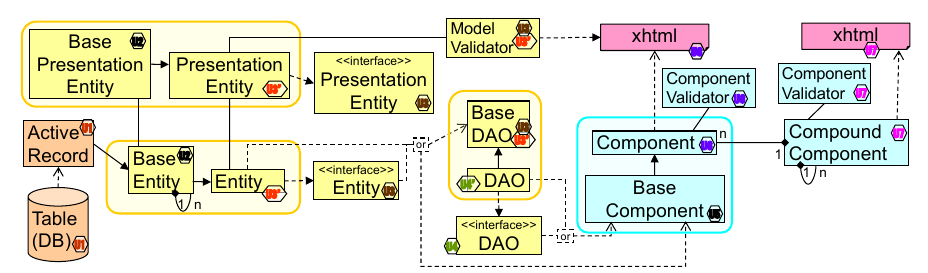
Figure 7: Class structure of DBPowder.